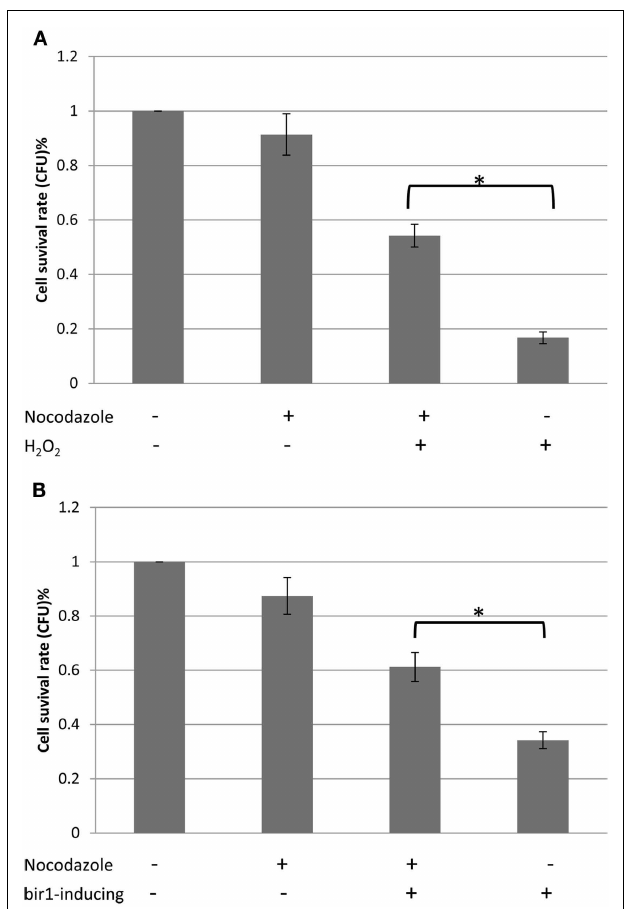
FIGURE 4 | Cell survival rates with or without nocodazole. (A) .Wild type cells were grown to early log phase. 10 µ g/ml nocodazole was then added to the culture medium for 2˚h, to block cells to pro-metaphase. Four millimolars of H 2 O 2 was added for 1˚h and 500 cells were plated onYPD plate. Colony forming unit (CFU) was calculated against control. (B) . BIR1-degron cells were grown inYPDCu (24˚C) to early phase. 10 µ g/ml nocodazole was then added to the culture medium for 2˚h, to block cells to pro-metaphase. Cells were then transferred toYPG (37˚C) for 1˚h, followed by plating assay. ∗ P < 0.05.